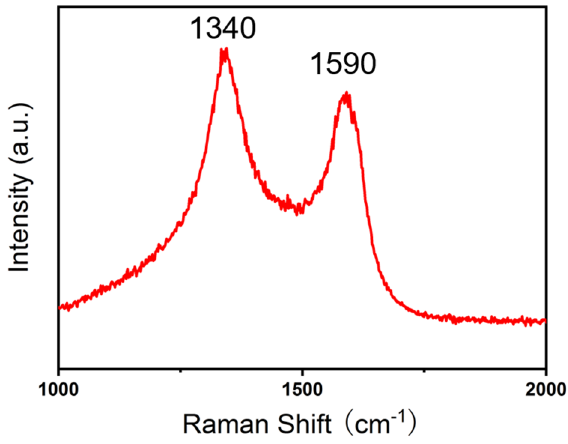
Figure 2. Raman spectra of Pt/Pd/Co-N-C.